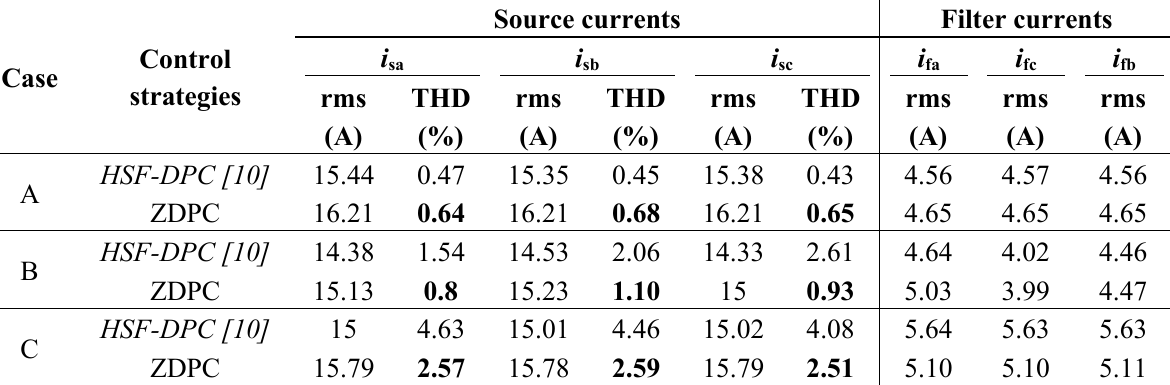
Table 5. Simulation results for HSF-DPC and ZDPC strategies under three cases (A, B, C).